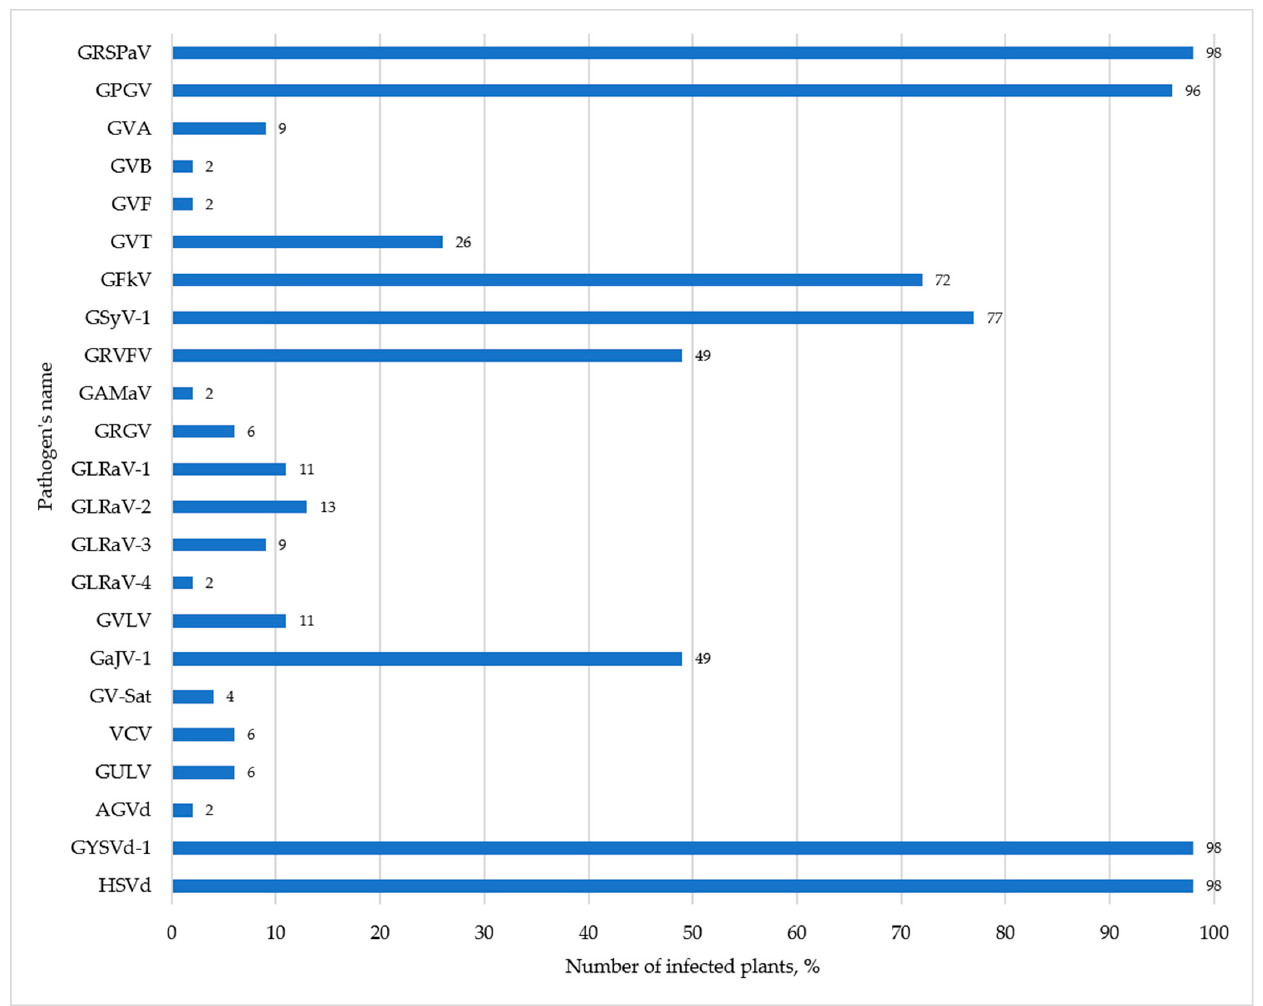
Figure 1. Frequency of distribution of grapevine viruses and viroids in Anapa Ampelographic Collection (percentage of the total number of collected samples).